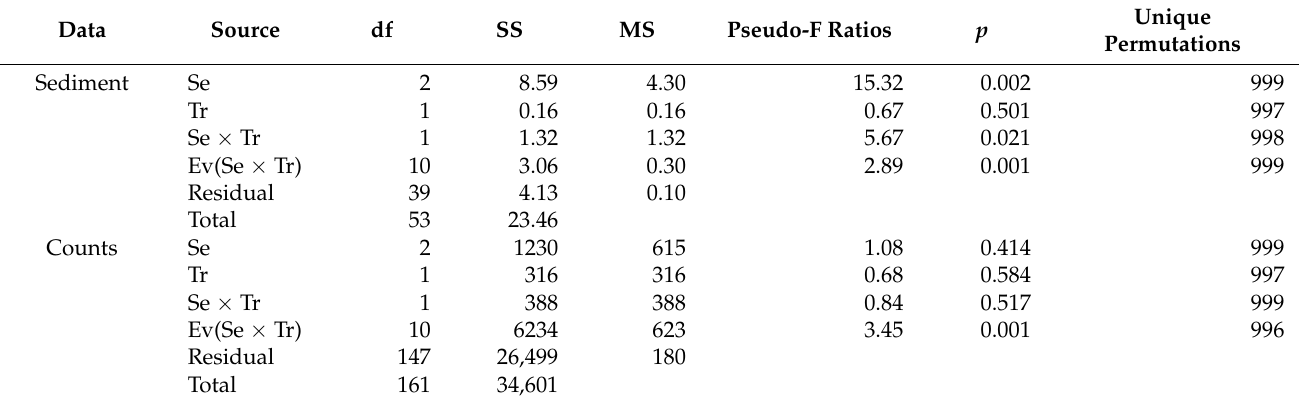
Table 2. Results of permutation analyses of variance. Se = type of sediment (muck in a creek, sediment that was not muck in a creek, and sediment in the lagoon), Tr = treatment (undisturbed or dredged), Ev = sampling event (before dredging, one month after dredging, and one year after